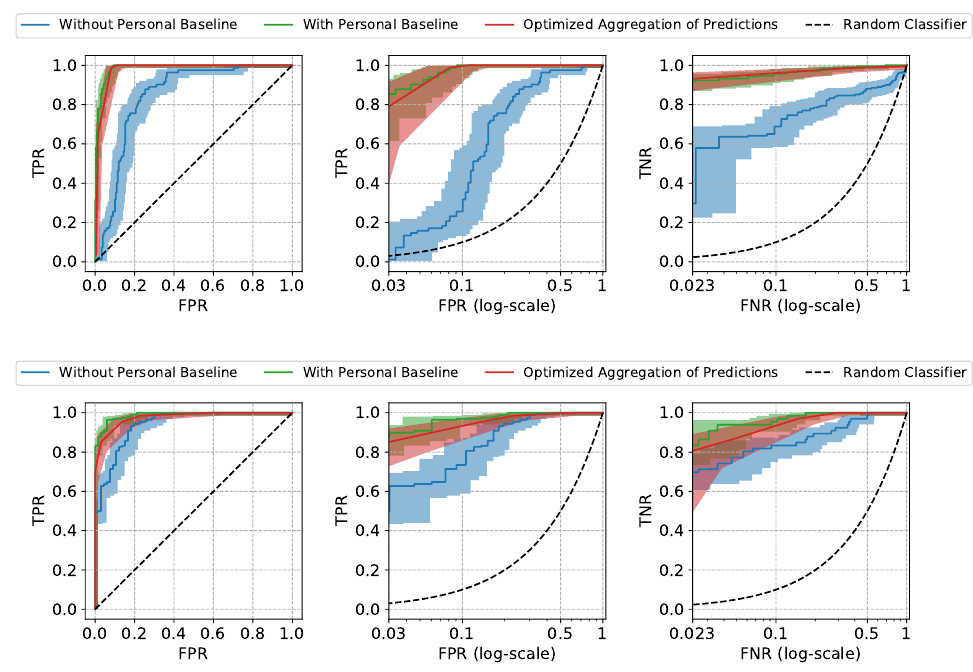
Figure 5. ROC curves of two example test subjects. The 95% confidence intervals are computed using the Wilson interval